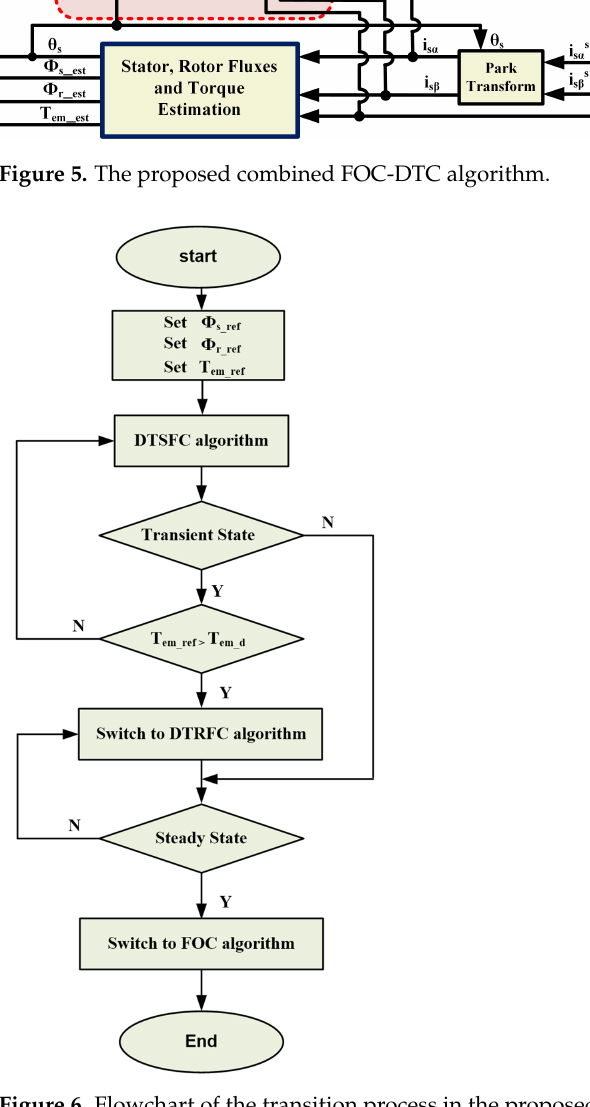
Figure 6. Flowchart of the transition process in the proposed combined FOC-DTC